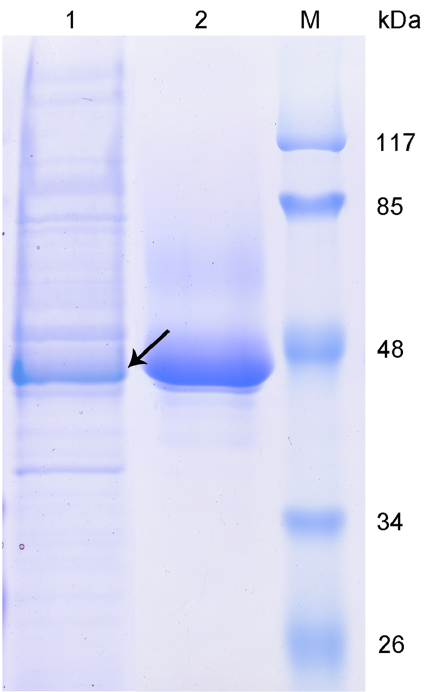
Figure 1. SDS–PAGE analysis of the purified Sp-SPH protein. The recombinant Sp-SPH protein was purified by using Ni2 + affinity chromatography via a 6 6 His tag as described above. Lane M, molecular weight marker; lane 1, purified Sp-SPH protein; lane 2, cultured medium from pPIC9K/Sp-SPH recombinant clone induced by methonal before protein purification.